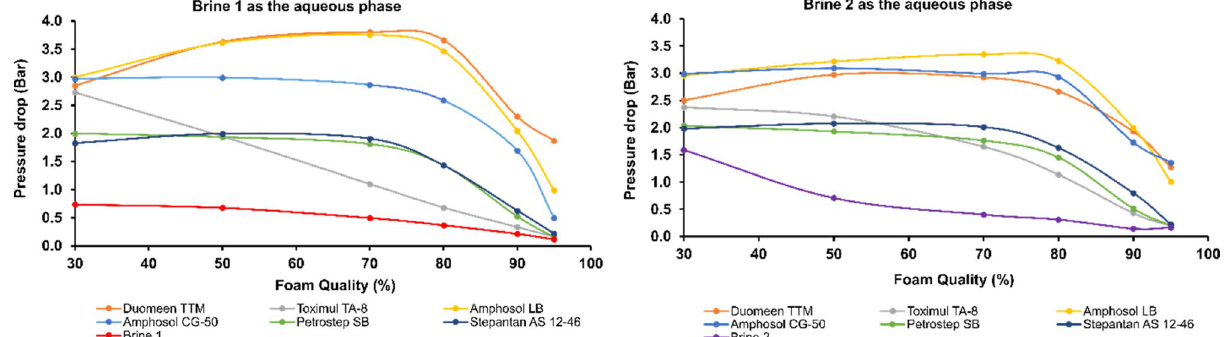
Figure 6. Pressure drop across the microfluidic analogue during injection of the aqueous and Sc-CO 2 phases. The plot on the left is for Brine 1 and on the right is for Brine 2 once used as an aqueous phase in the presence and absence of surfactants. Concentration of surfactants for all cases is 0.5